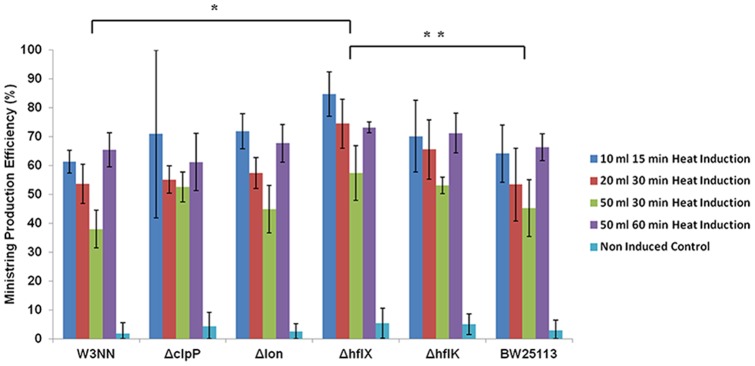
Effect of protease mutation on DNA ministring production efficiency.LCC DNA ministring production efficiencies were assessed at various culture volumes and heat induction durations for strains possessing various protease associated gene deletions (ΔclpP, Δlon, Δhflx, Δhflk) and isogenic Tel+ strain (BW25113). Across all conditions, the introduction of hflX gene deletion conferred significant increases in ministring production efficiencies over the original Tel+ wild type cells (W3NN) carrying the parent plasmid (pNN9) * (P≤0.01) and isogenic Tel+ cells (BW25113) carrying pNN9 ** (P<0.05).